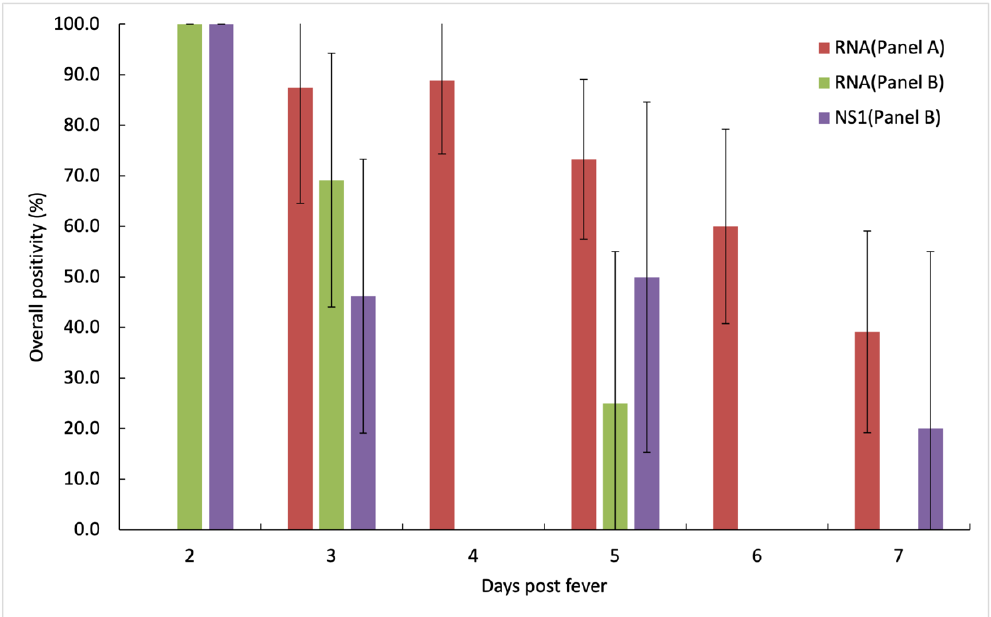
Figure 4. Comparative analysis of detection of dengue viral RNA and NS1 antigens in saliva samples collected in Panel B. Similar to Panel A, positivity of DENV RNA showed a downward trend as the disease progressed and diminished from day 6 onwards. DENV NS1 positivity in saliva also showed a downward trend but it remained detectable at day 7 after fever onset. The whiskers represent 95% CI for each sample. Overall positivity of Panel B (RNA/NS1) is 34.2%/36%.